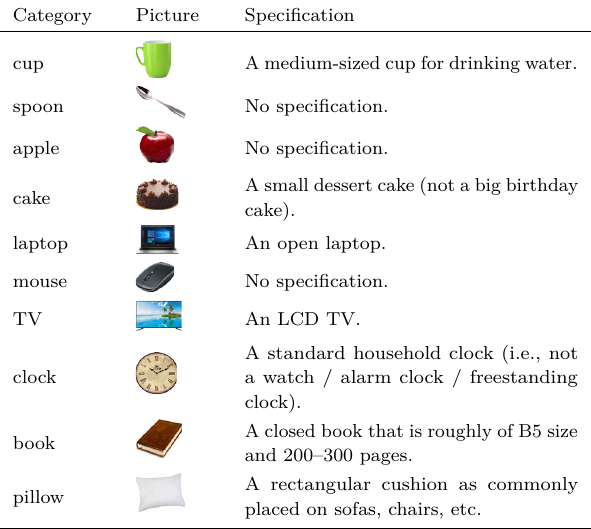
Table 2 Insertable object categories considered in this